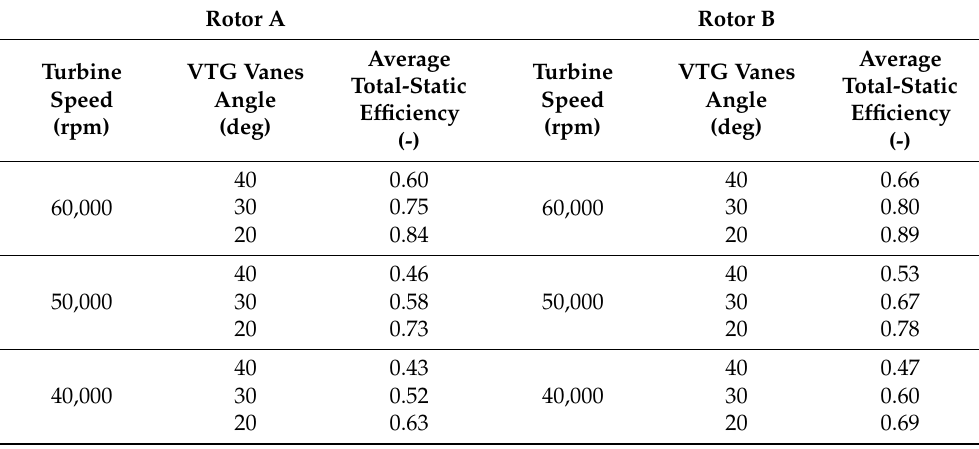
Figure 33. The changes of the second-stage rotor efficiency with two different rotor geometries at three different turbine speeds and VTG positions: ( a ) rotor A at 60,000 rpm, ( b ) rotor B at 60,000 rpm, ( c ) rotor A at 50,000 rpm, ( d ) rotor B at 50,000 rpm, ( e ) rotor A at 40,000 rpm, ( f ) rotor B at 40,000 rpm. Table 15. The average total-static efficiency values of the second-stage rotor for two different rotor